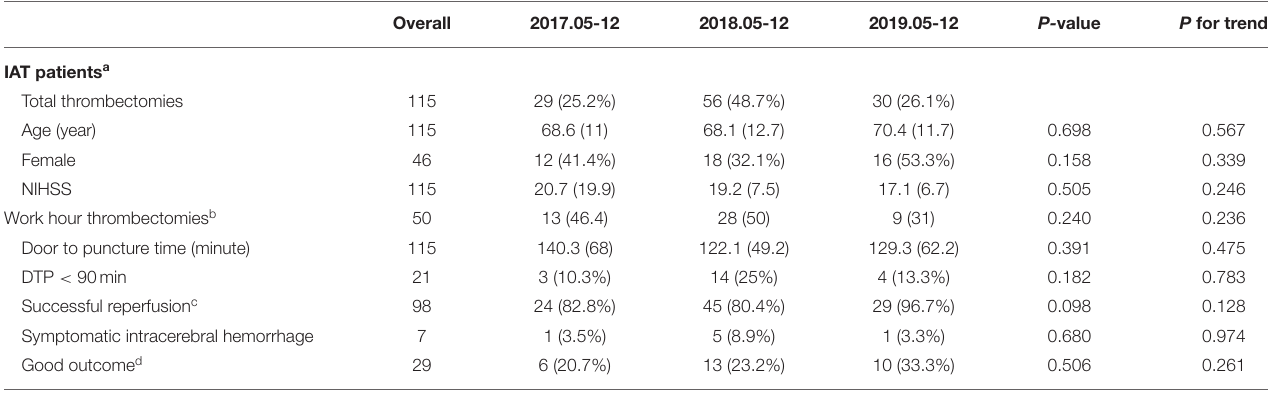
TABLE 2 | Characteristics of non-transfer cases with intra-arterial thrombectomy of the three periods.